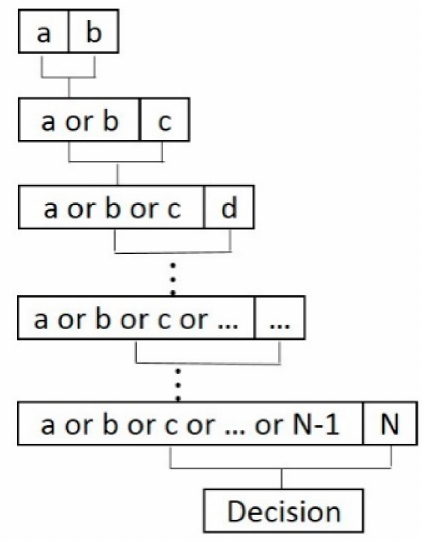
Figure 3. Hierarchical one vs. one (OAO).